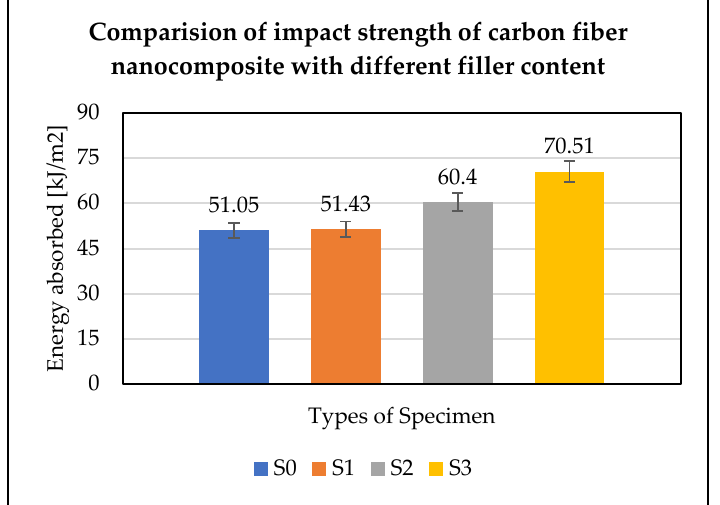
Figure 7. Impact strength.